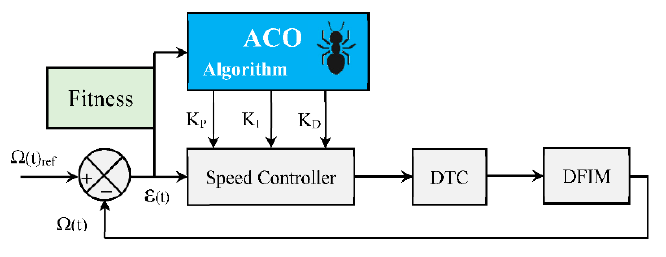
Figure 7. Reduced scheme of the PID-DTC optimized by ACO.